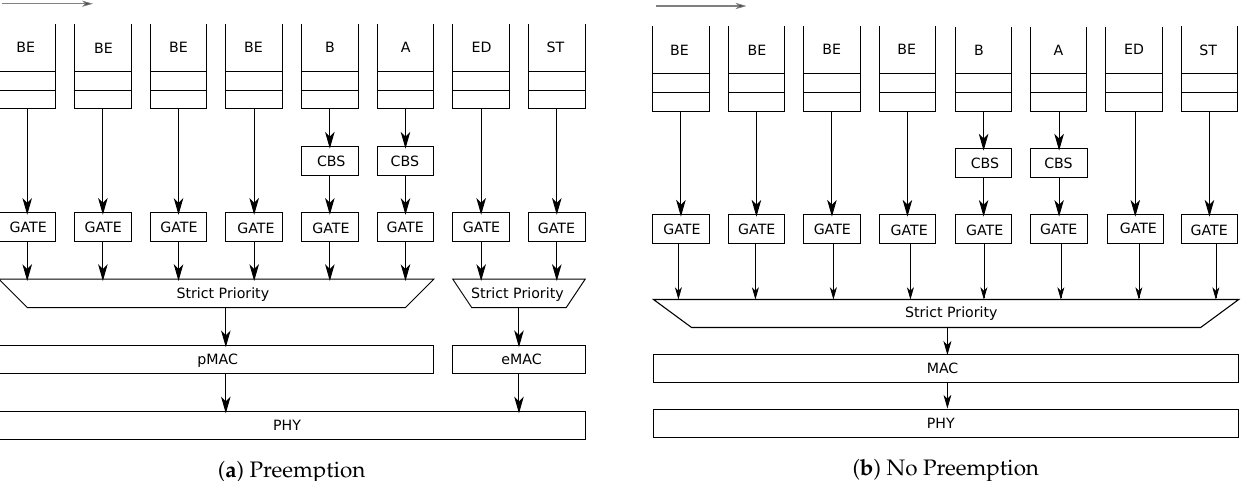
Figure 2. ED class mapping on the priority queues of a sample switch port. Case ( a )-Preemption enabled. Case ( b )- No